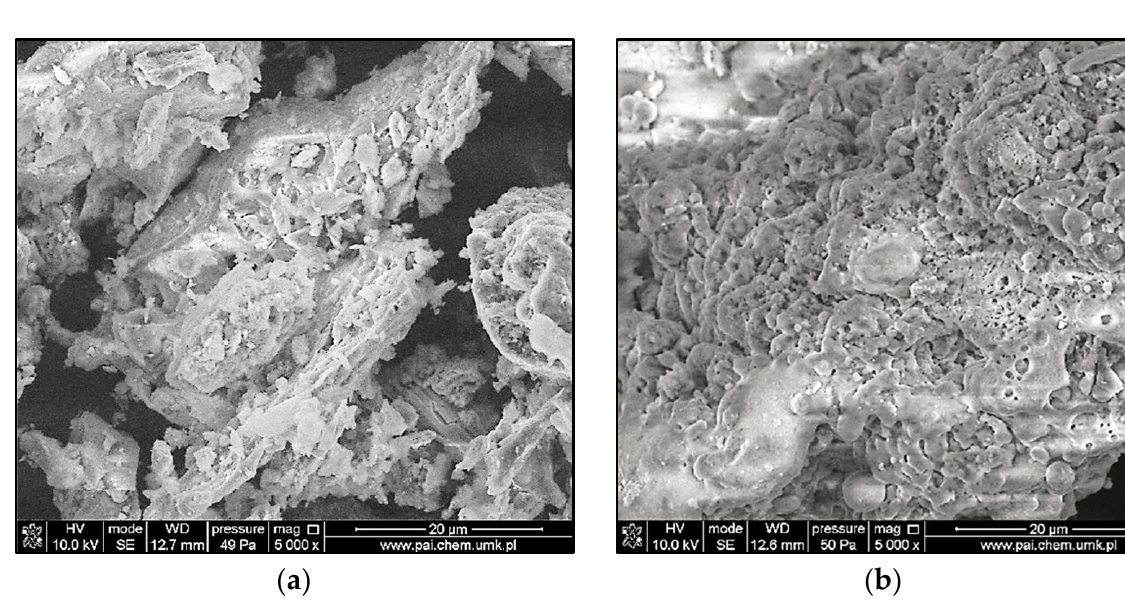
Figure 1. Scanning electron microscopy (SEM) image at 5000x magnification of the blast furnace slag (BFS) ( a ) and coal slag (CS) ( b ).